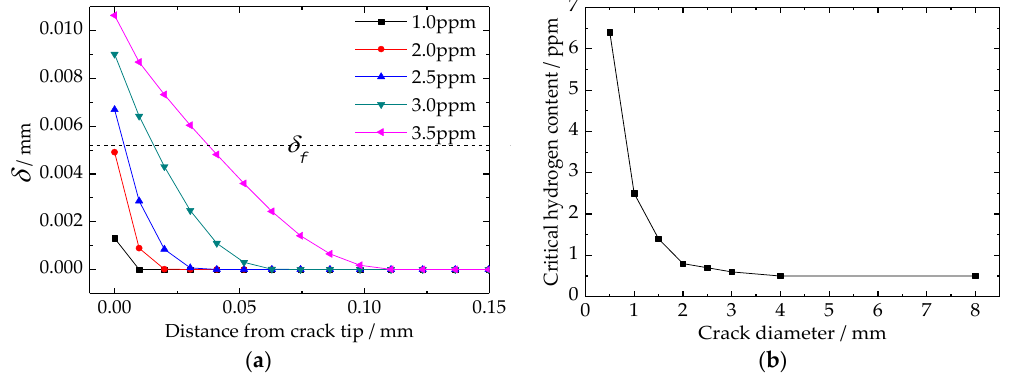
Figure 10. Critical hydrogen content for flake formation in Cr5VMo steel: ( a ) separation of the cohesive element around the crack tip; ( b ) influence of crack diameter.